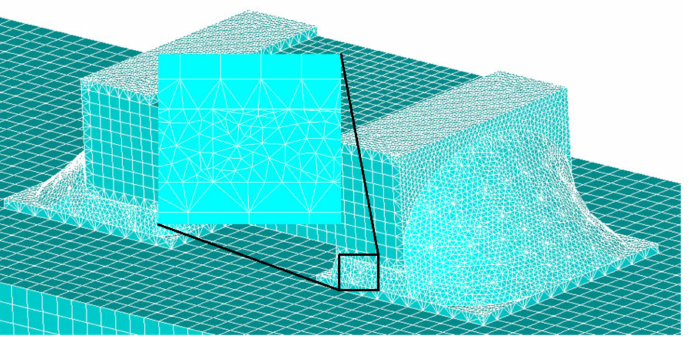
Figure 6. The 3-D meshed model.